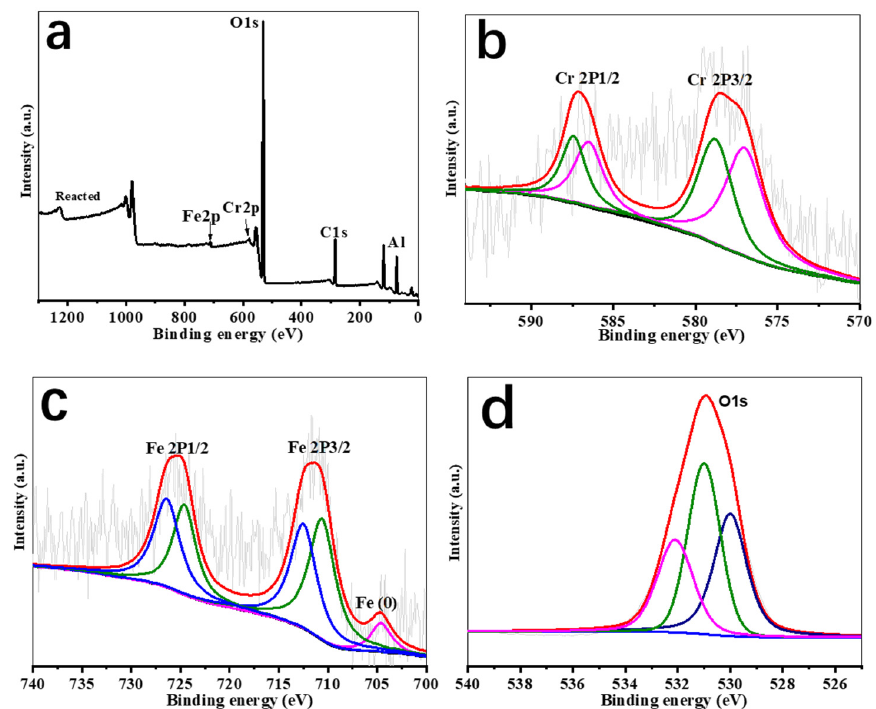
Figure 6. XPS spectra of ZVI-ALOX after the Cr(VI) removal reaction: ( a ) wide scan survey spectrum; ( b – d ), high resolution spectra of Cr 2p, Fe 2p and O1s.